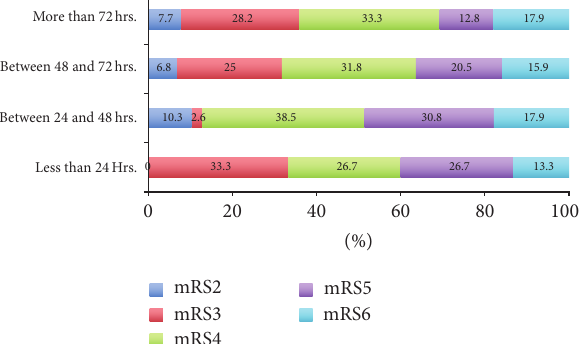
Figure 2: Outcome at three months with DHC stratified by time to surgery ( 𝑃 = 0.747